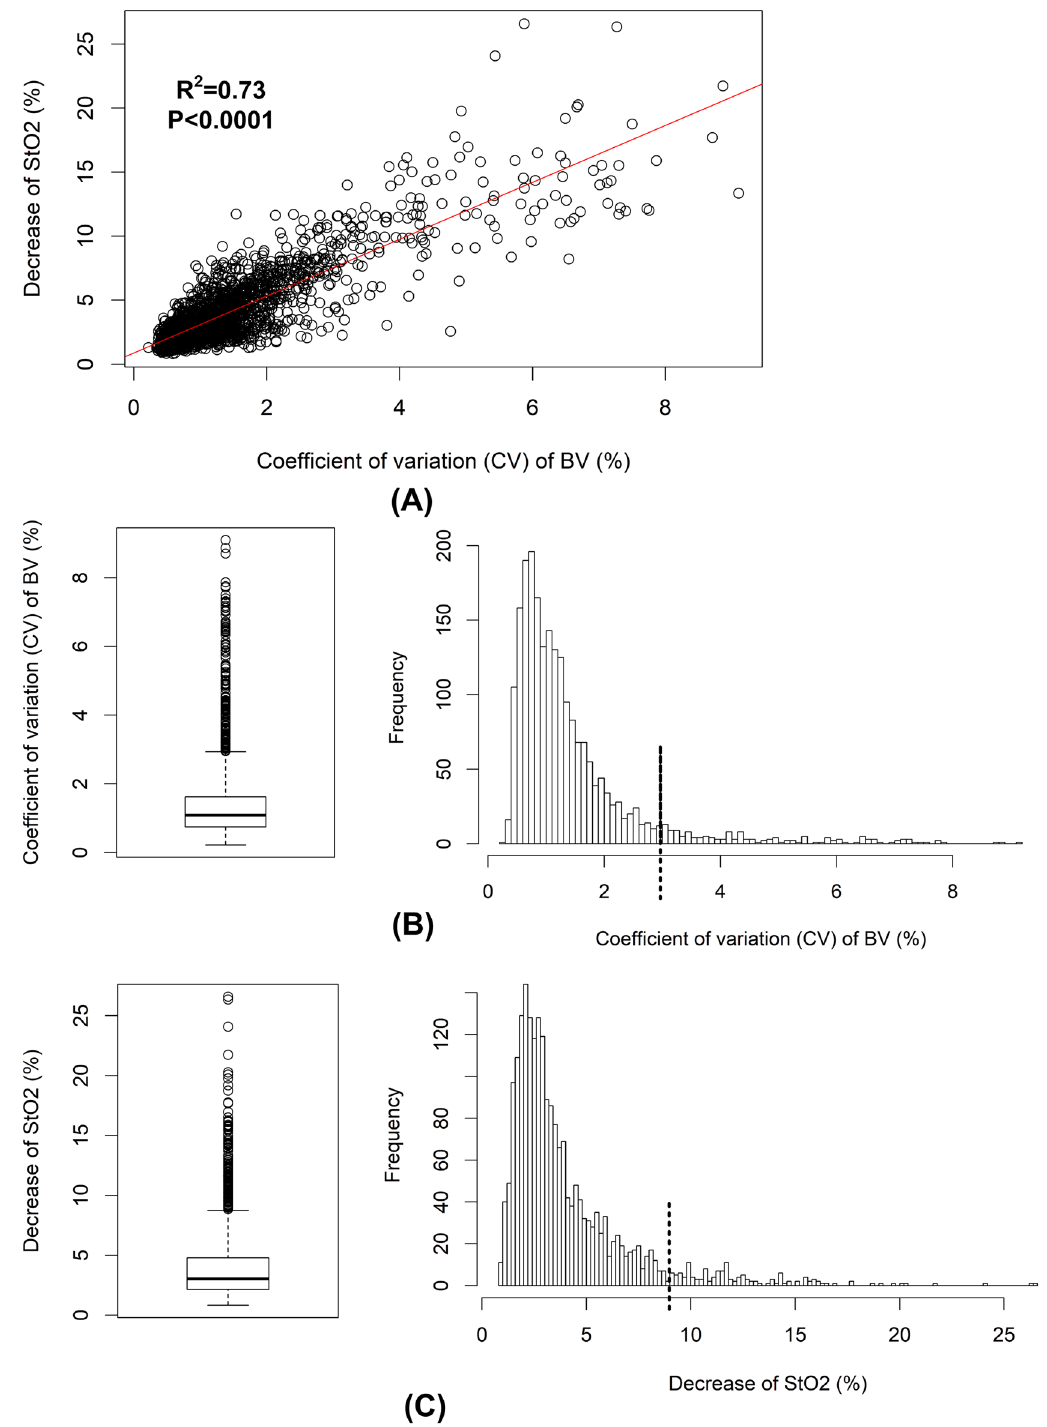
Figure 3. The distributions of the coefficient of variation (CV) of cerebral blood volume (BV) and the decrease of cerebral StO2 (de-StO2). Changes in CV of BV and de-StO2 are correlated as shown in ( A ). The box plot suggests the outliers of CV of BV are larger than 3% and the cut-off 3% is marked with the dash line in its distribution ( B ). Similarly, the cut-off for outliers is 8.7% as shown in the box plot of de-StO2 and it is marked with the dash line in the distribution ( C